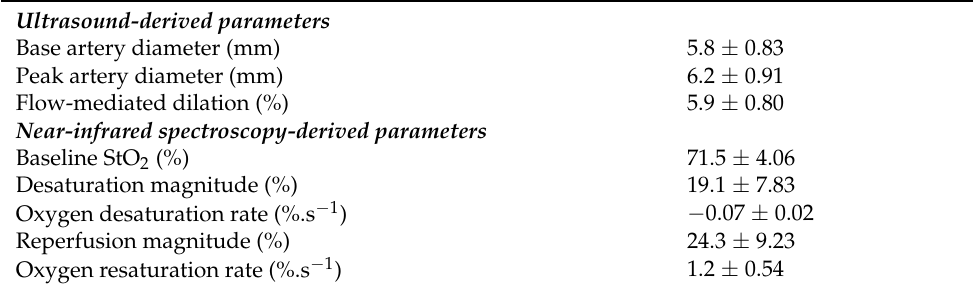
Table 2. Flow-mediated dilation (FMD) and muscle oxygen saturation (StO 2 ) parameters throughout a vascular occlusion test in healthy, young